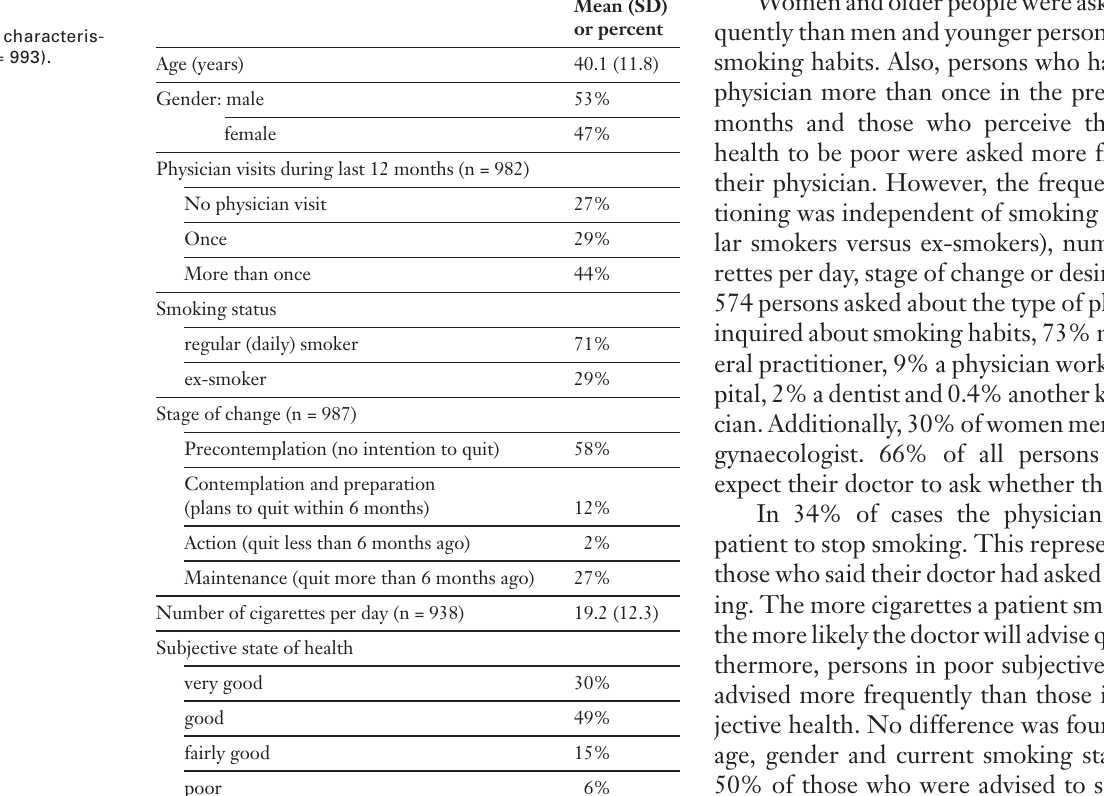
Sample characteris- tics (n = 993).